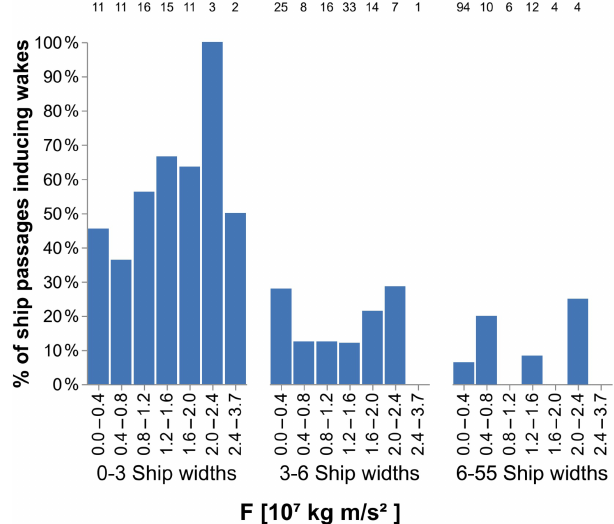
Figure 6. Wake occurrence for three different passing distances: 0– 3, 3–6, and 6–55 ship widths from the instrument. For each distance, the x axis shows the force ( F ) of the passing vessel in newton. The number above each bar indicate the total number of passages for that passing distance. Note the cut-off in percentage of detected wakes at passing distances greater than three ship